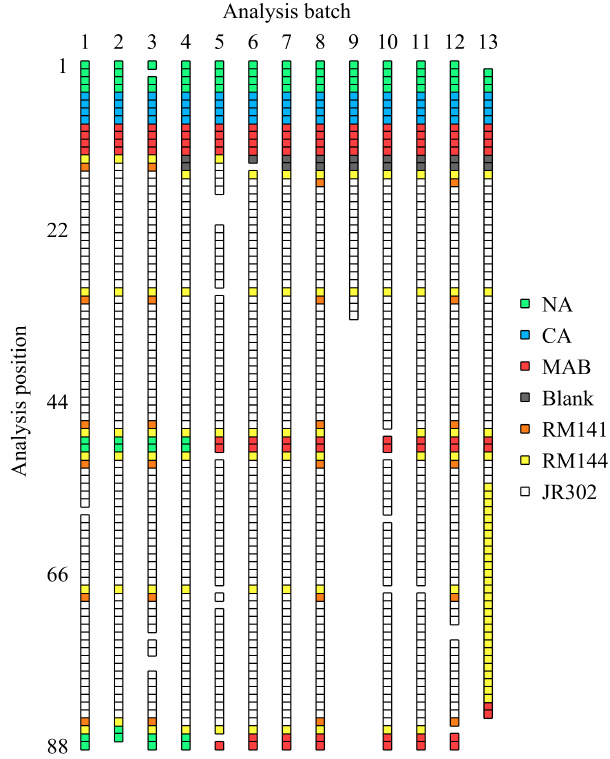
Figure 2. Schematic arrangement of calibration standards (NA, CA and MAB), blanks, RM and samples (JR302) within each analysis batch. Each square represents a separate measurement (i.e. a set of 10 technical replicates). Gaps are left where results have failed qual- ity